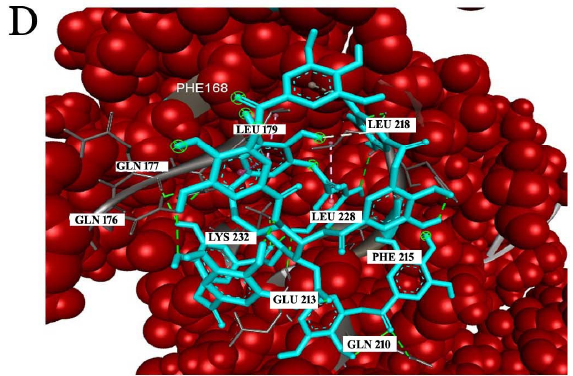
Figure 4. Molecular docking of ligands with fibrinogen. ( A ) Fibrinogen represented as a CPK model; expanded view of the ligands showing their interactions with the critical residues of fibrinogen; ( B ) rutin; ( C ) tannic acid; ( D ) resveratrol. 2.3.3. Interaction Analysis with Human Glutathione Peroxidase 3 (GPX3)